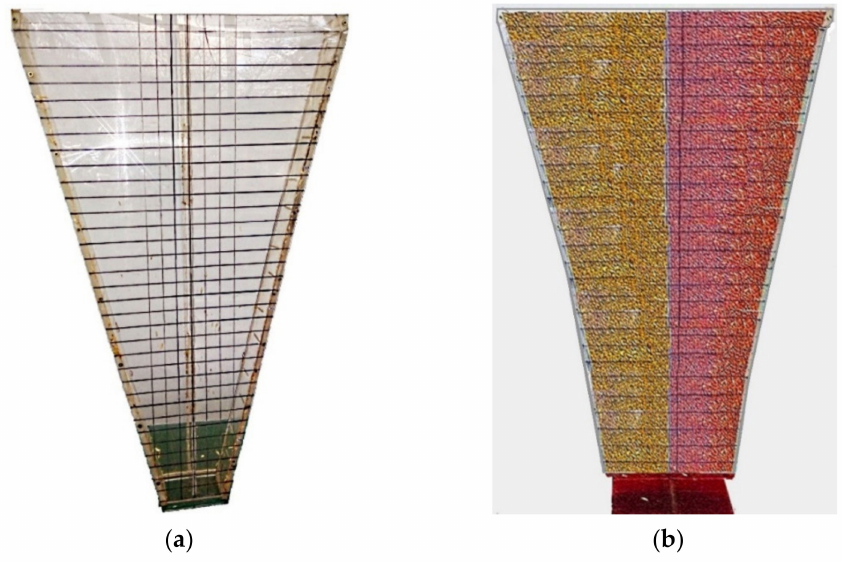
Figure 6. Appearance of experimental hopper model: ( a ) empty model; ( b ) model filled with grain. Studies were carried out for various rates of grain flow through the outlet hole, for which purpose the area of the cross-section was controlled with a latch. The cross-section area varied in range from 0.0011 m 2 to 0.0042 m 2